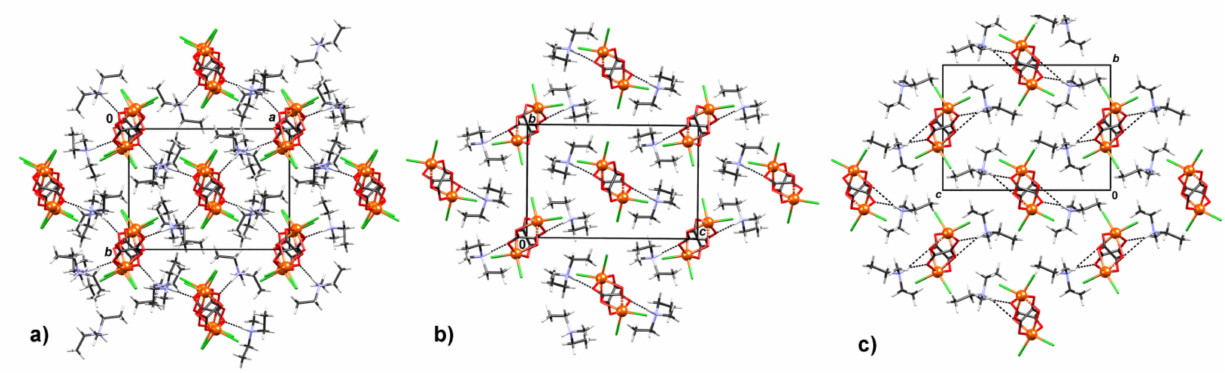
Figure 2. Packing of the [FeCl 2 (C 2 O 4 )] nn − chains in ( a ) LT , ( b ) MT , and ( c ) HT structures of coordination polymer